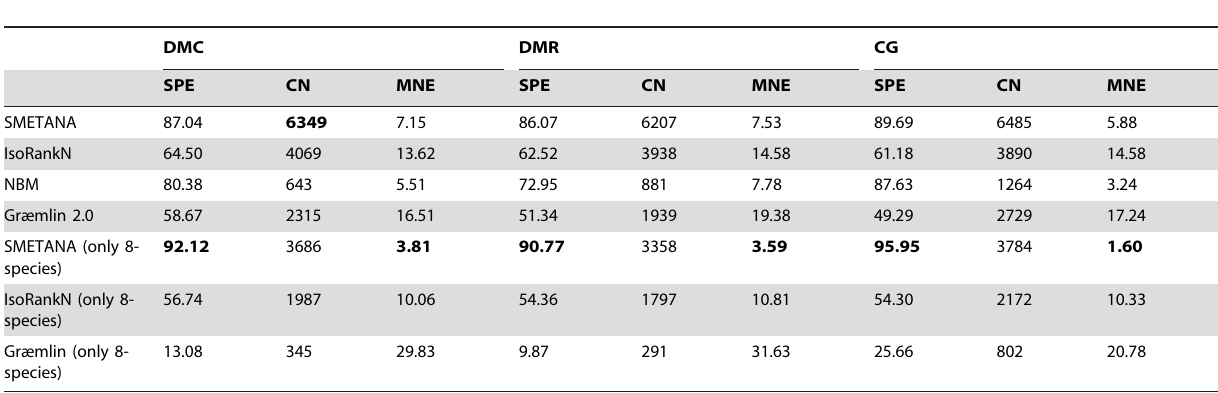
Performance comparison based on the 8-way alignment of eight networks of equal size 1,000. The last three rows are obtained by considering only equivalence classes that contain at least one node from every species. The performance of each method is assessed using the following metrics: specificity(SP), number of correct nodes (CN), and mean normalized entropy (MNE). In each column, best performance is shown in bold. doi:10.1371/journal.pone.0067995.t003 PLOS ONE |